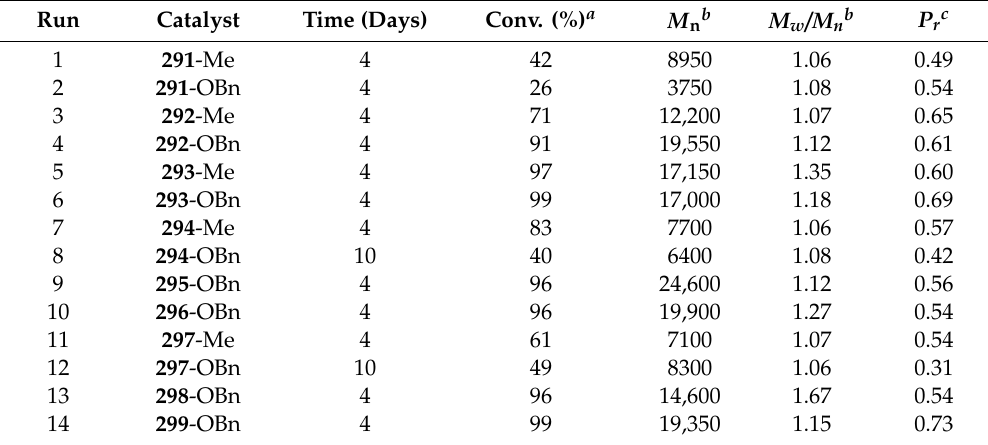
Table 10. ROP of rac -LA catalyzed by 291–299 (Me- and BnO-derivatives) [126].